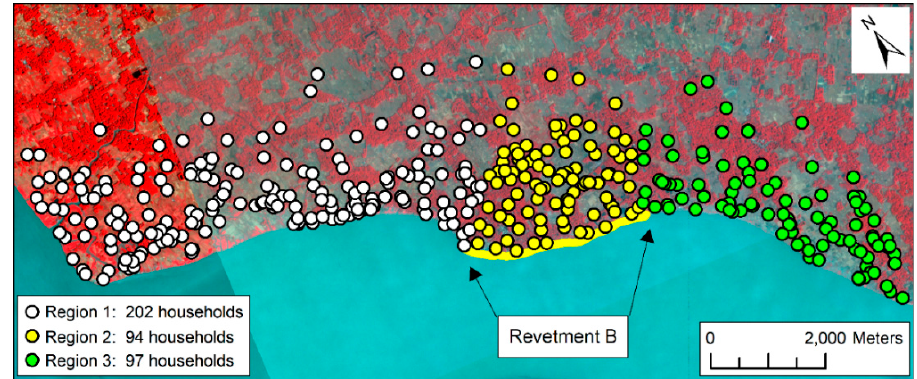
Figure 5. Sampled household locations by region in Ramgati Upazila; Region 2 is protected by a revetment; household location confidentiality was preserved by randomly shifting ± 50 m in the x and y directions along with the choice of map scale and point symbol size; background image is a PlanetScope (3.7 m pixel) false color composite dated 6 January 2019 [48].